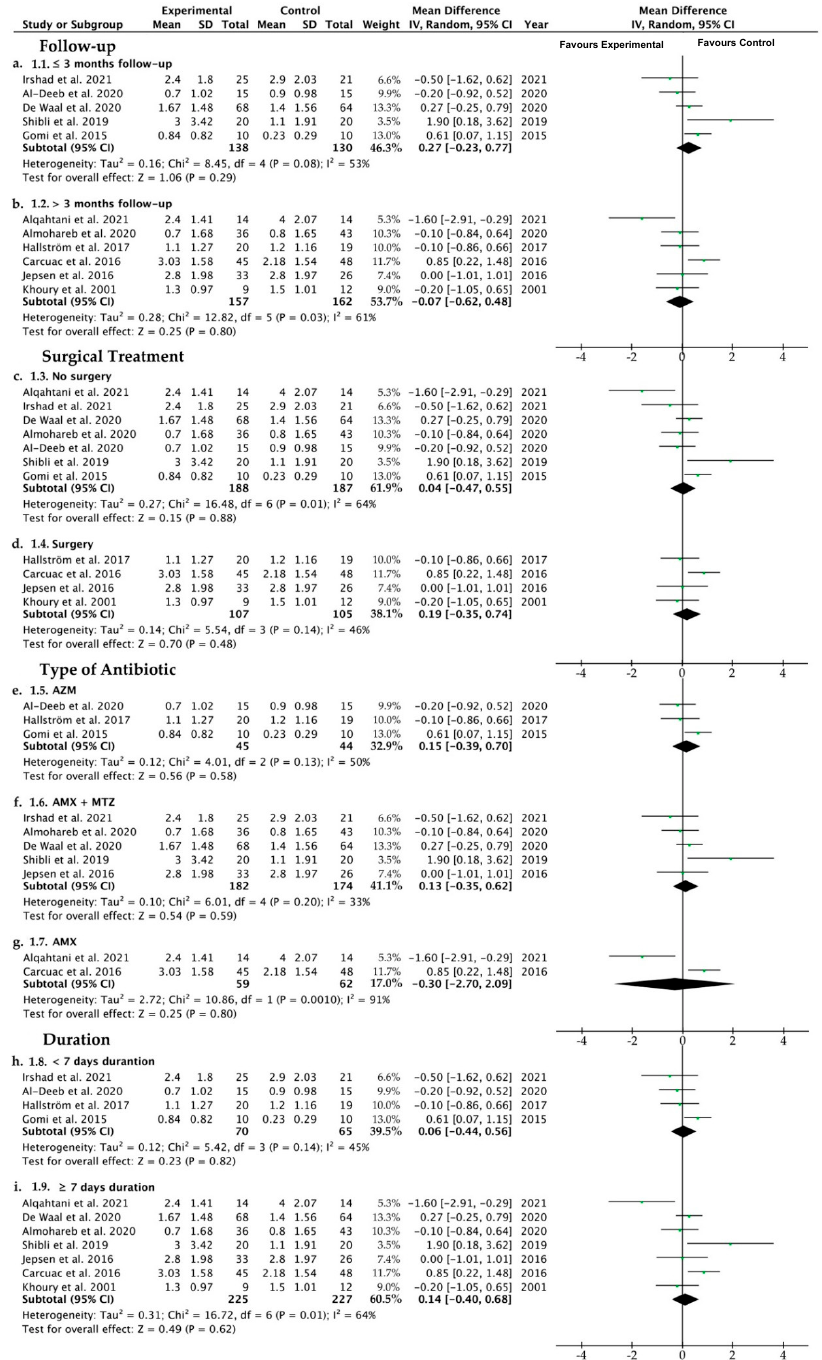
Figure 7. Forest plot for no systemic antibiotic (control group) versus adjunct systemic antibiotic (test group) when comparing peri-implant probing pocket depth (PPD) after ( a ) three months or less of follow-up, ( b ) more than 3 months of follow-up, ( c ) performing an implant exposure surgery or open flat debridement, ( d ) performing non-surgical subgingival debridement, ( e ) azithromycin as adjunct systemic antibiotic, ( f ) metronidazole plus amoxicillin as adjunct systemic antibiotic, ( g ) amoxicillin as adjunct systemic antibiotic, ( h ) less of 7 days of antibiotic administration, and ( i ) more than 7 days of antibiotic administration. Weighted mean is presented at CI 95%. Heterogeneity was determined using Higgins (I 2 ). A random-effects model was applied in all the analyses. Statistical significance was set at 0.05